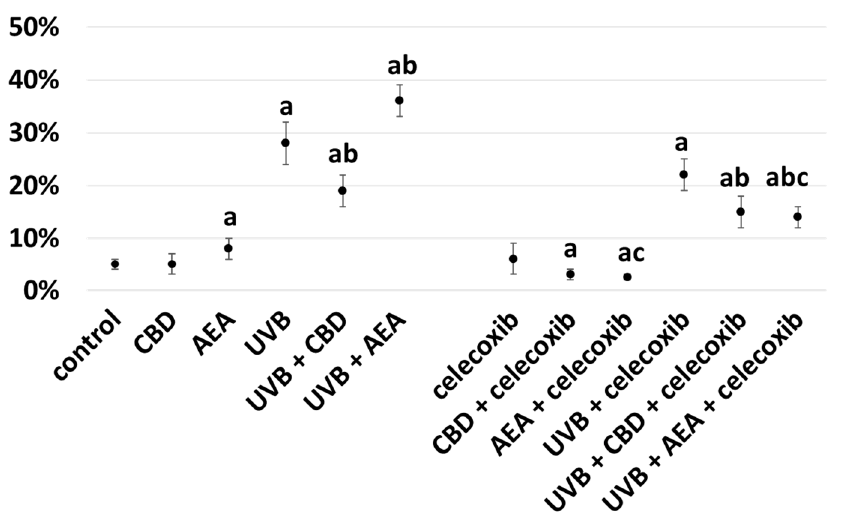
Figure 2. Percentage of cells undergoing apoptosis in control keratinocytes treated with CBD (4 µ M) or AEA (4 µ M) or irradiated with UVB (60 mJ/cm 2 ) as well as cells irradiated with UVB and treated with CBD or AEA (in the same concentrations), as well as their expression in keratinocytes after treatment with 20 μ M celecoxib alone and with CBD(4 μ M) or AEA(4 μ M) as well as cells irradiated with UVB and treated with CBD or AEA (in the same concentrations). (a)—statistically significant differences between keratinocytes treated with CBD, AEA, UVB, UVB + CBD, AEA + UVB and control cells as well as keratinocytes treated with CBD + celecoxib, AEA + celecoxib, UVB + celecoxib, UVB + CBD + celecoxib and AEA + UVB+ celecoxib and cells treated only with celecoxib; p < 0.05; (b)—statistically significant differences between keratinocytes treated with UVB + CBD, UVB + AEA, UVB + CBD + celecoxib, AEA + UVB + celecoxib and irradiated with UVB p < 0.05; (c)—statistically significant differences between keratinocytes treated with celecoxib and corresponding keratinocytes not treated with celecoxib.